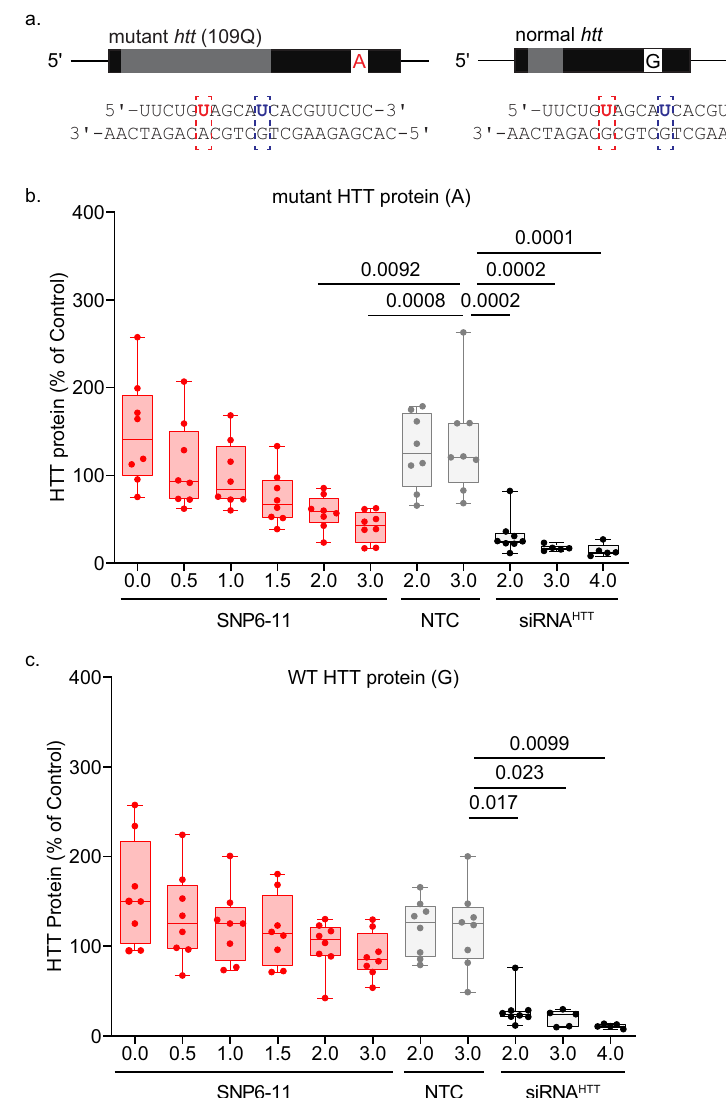
Fig. 4 | SNP6-11 siRNA maintains selective-silencing of mutant HTT in patient- derivedNSCs. HDpatientderivedneuralstemcellscarrying anAoraGatSNP site rs362273 ( a ) were treated for 5 days with SNP6-11 or non-selective siRNA HTT at the concentrations listed. Graphs show pixel intensity quanti fi cation of mutant ( b ), or wild-type ( c ) HTT signal intensity standardized to that of vinculin reported as a percentage of untreated NSCs. A non-targeting control (NTC) siRNA was used as a